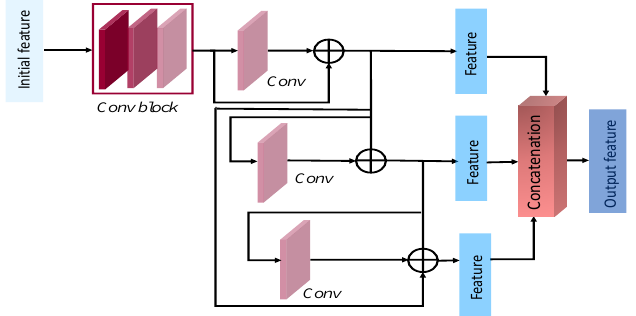
Figure 6. Densely residual feature extraction